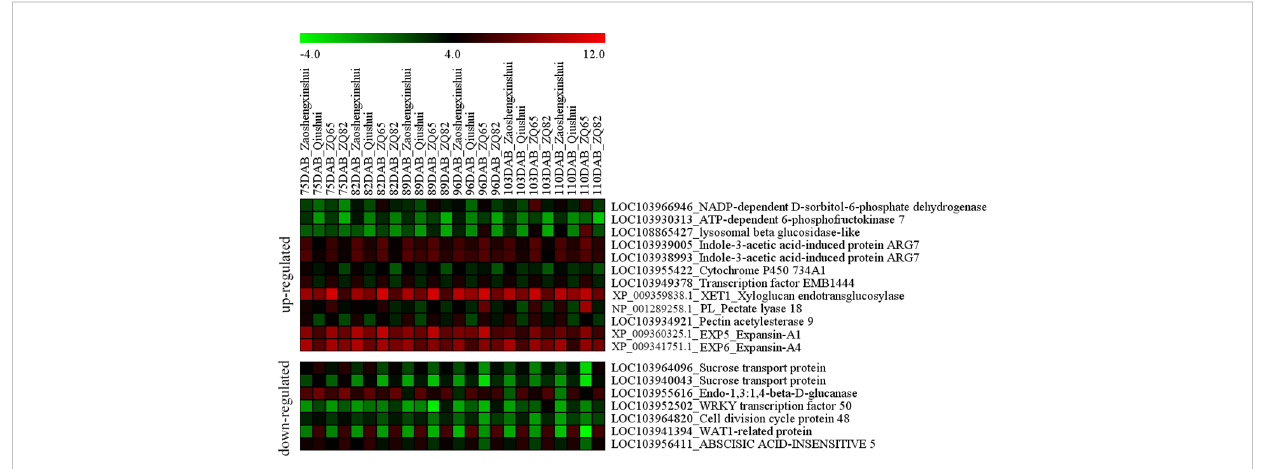
FIGURE 6 Heatmap of the differentially expressed genes in the fruit ripening of four pear cultivars ( “ Zaoshengxinshui, ” “ Qiushui, ” “ ZQ65, ” and “ ZQ82 ” ).